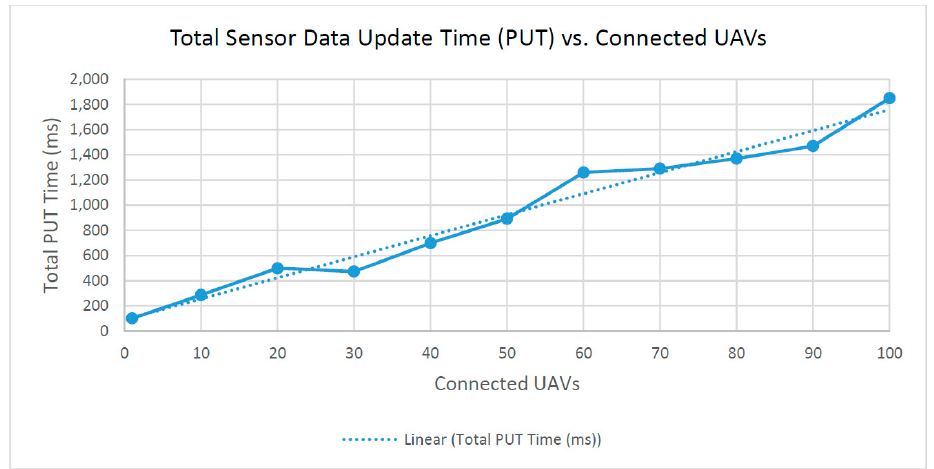
Figure 9. Total time to complete sensor data update.